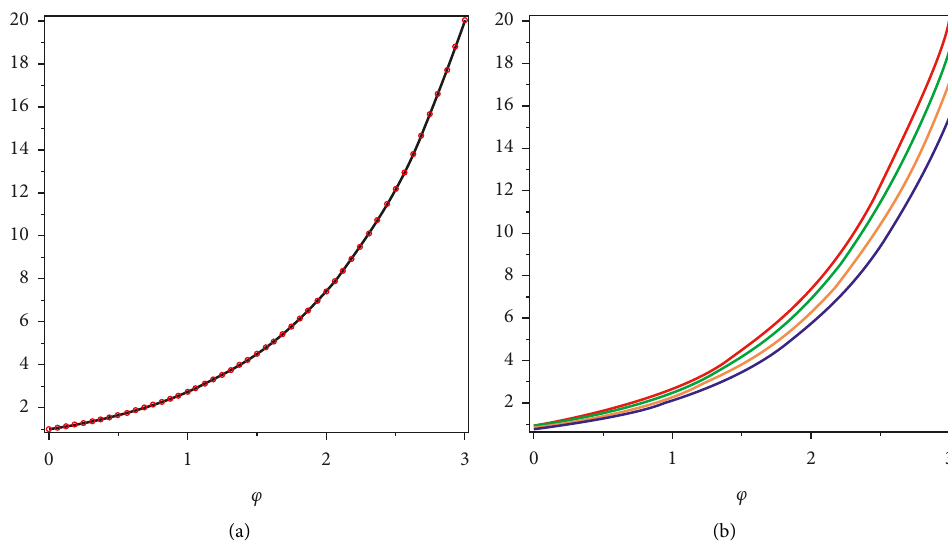
Figure 9: (a) The exact and approximate solution at δ � 1 and (b) the different fractional order of δ .